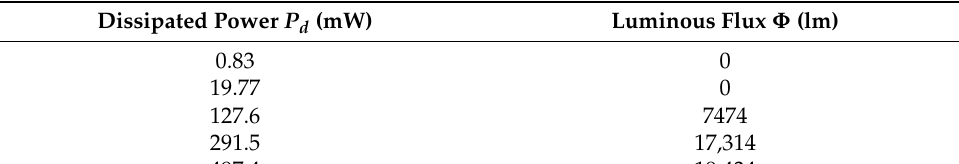
Table 1. The measurements of the LED (Crescent D01-A1-A33).